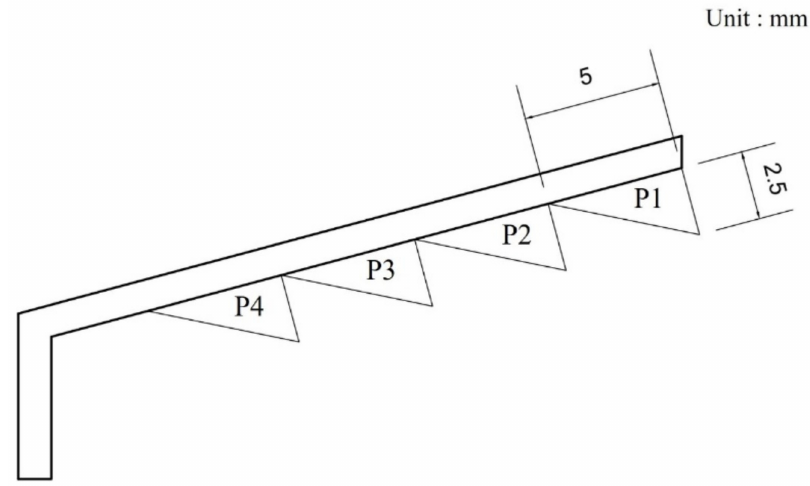
Figure 17. Schematic diagram of different actuation positions with 5 mm actuation length on inner surface (upper part).